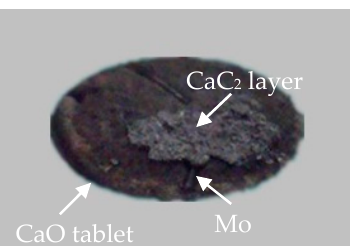
Figure 8. Location of Mo wires after the sample (ash-C+CaO with Mo wires) after the heat treatment at 1700 °C.